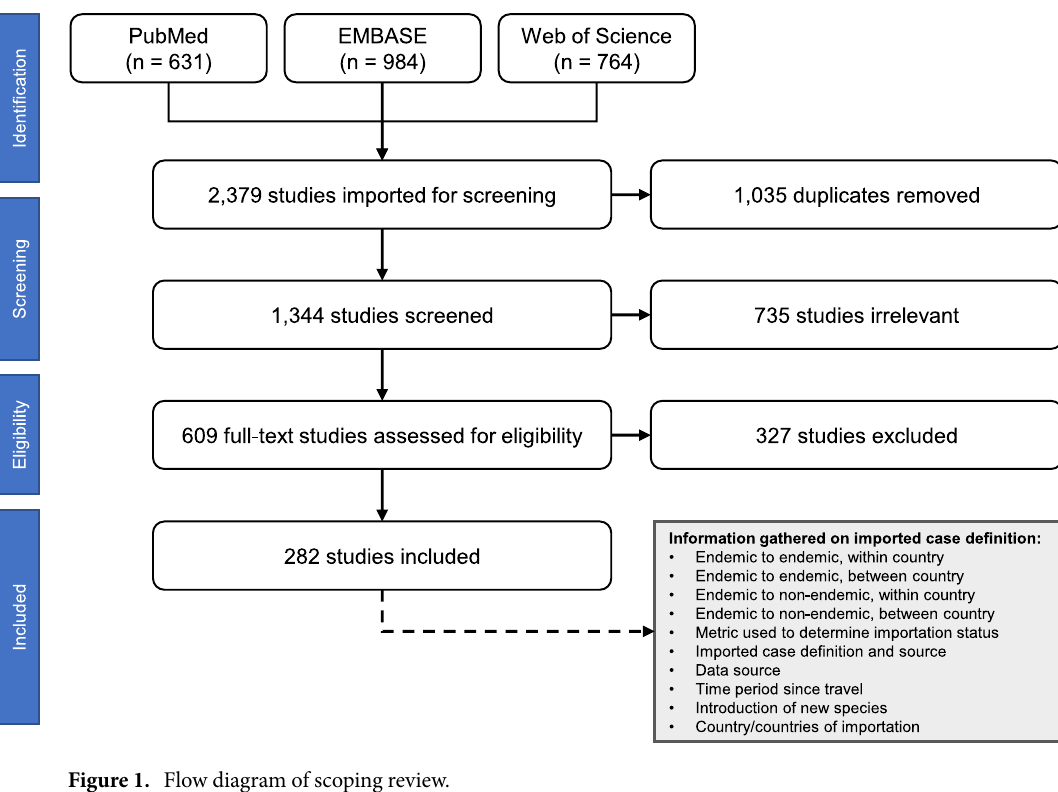
Figure 1. Flow diagram of scoping